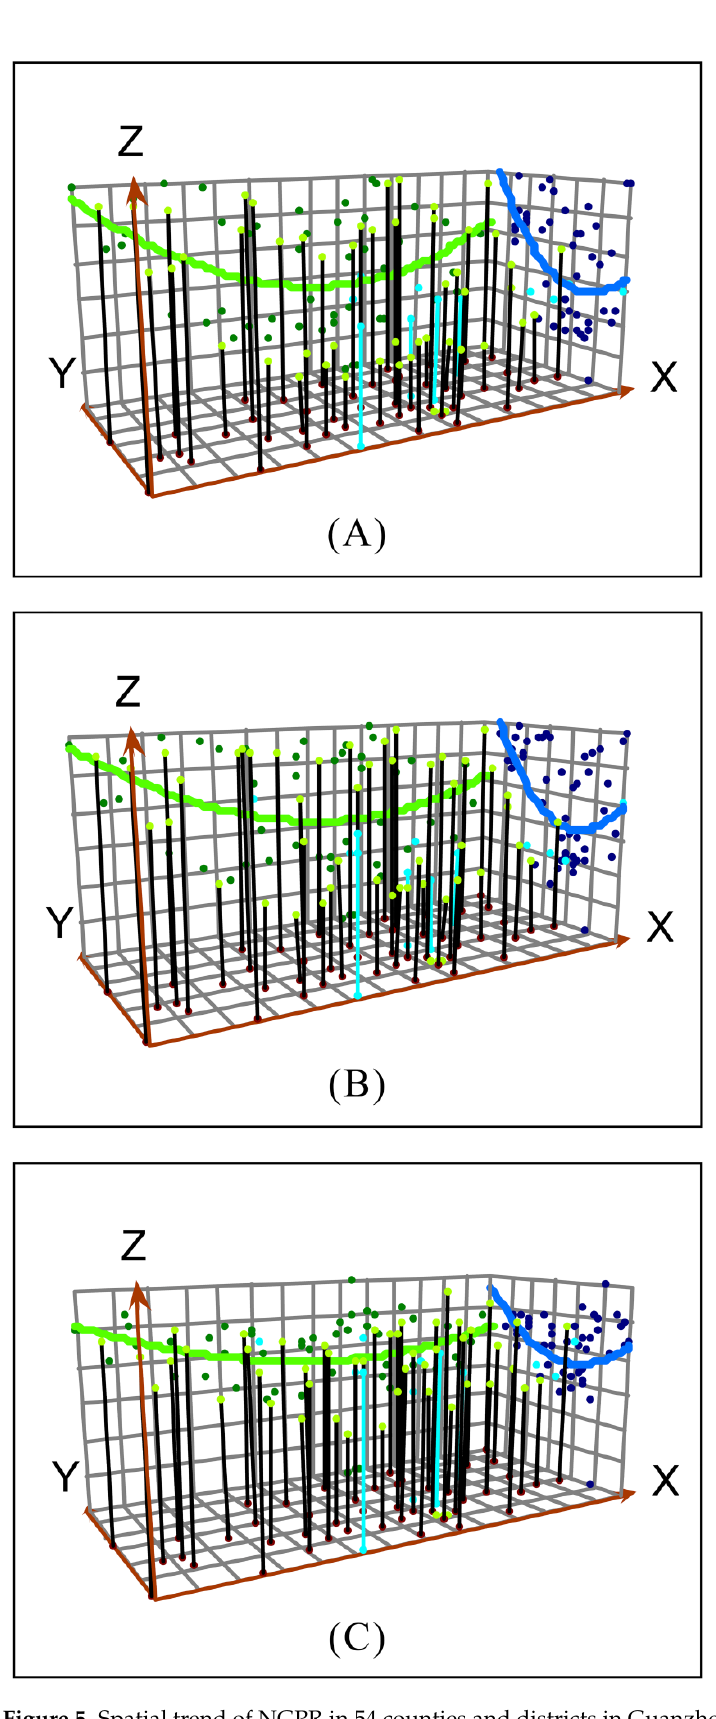
Figure 5. Spatial trend of NGPR in 54 counties and districts in Guanzhong: ( A ) 2000, ( B ) 2010, and ( C ) 2019.